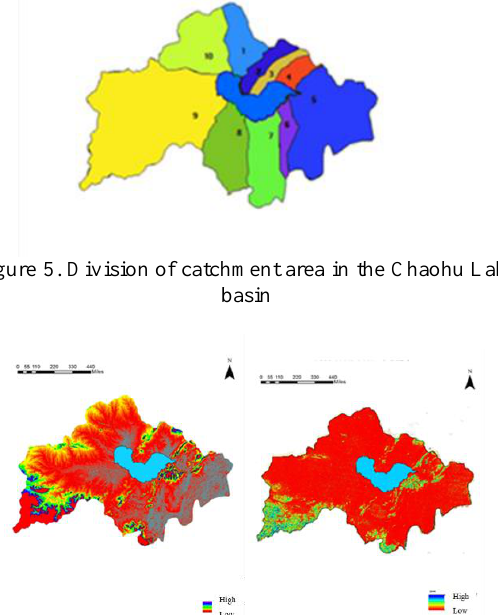
Table 3. Buffer zone width setting